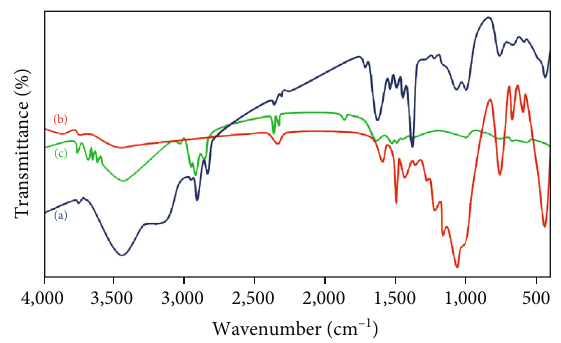
Figure 7: Infrared spectra of (a) virgin epoxy coating, (b) 5% titanium-embedded epoxy coating, and (c) 10% titanium- embedded epoxy coating after 260 hours of salt spray